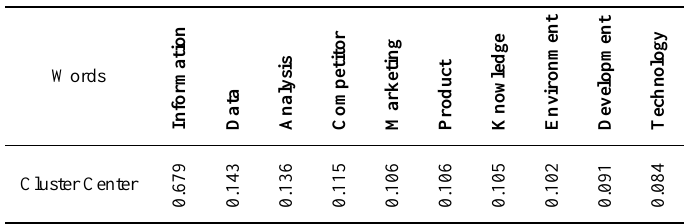
Table 3. Words and final centers of first cluster.